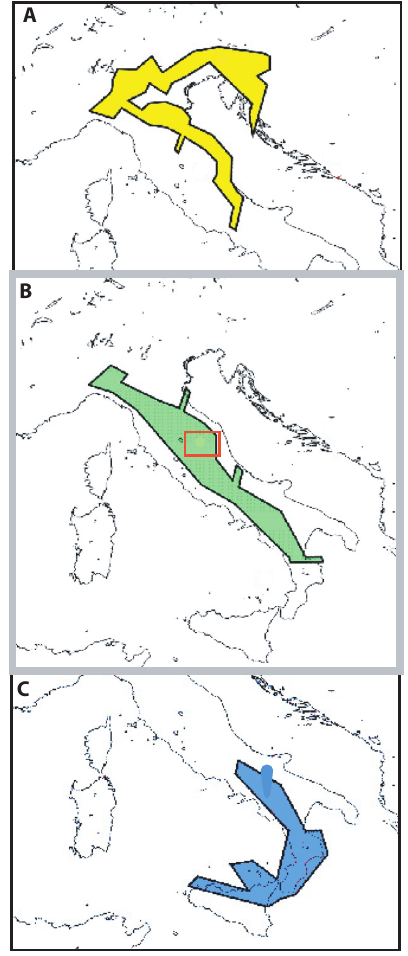
Fig. 6. Target areas for earthquake predictions of M 5.4+ (A - North) and 5.6+ (B - Center and C - South Italy) made with CN algorithm in Italy (Peresan et al ., 1999). The red box indicates the region where Umbria-Marche earthquakes